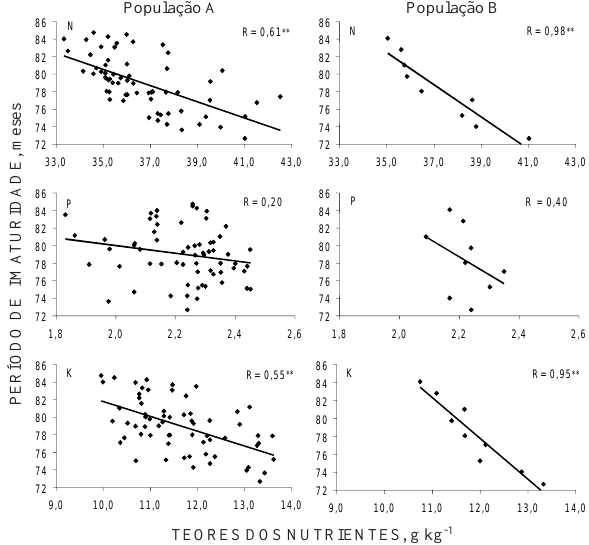
Figura 1. Relação entre teores foliares e período de imaturidade de seringueiras para dados individuais de todas as parcelas (População A) e média de nove estratos (População